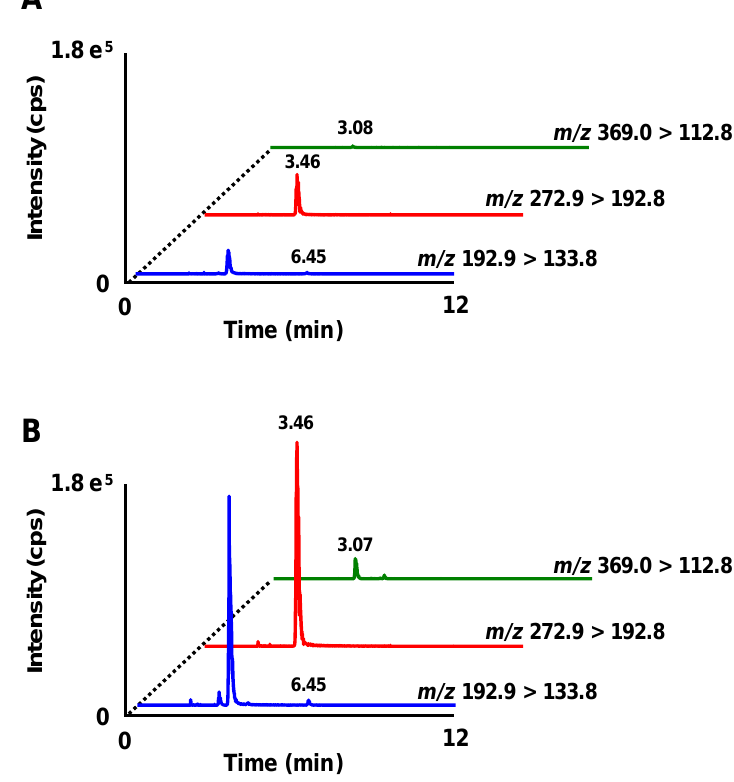
Figure 4. Typical MRM chromatograms of FA and FA conjugates in plasma before ( A ) and 6 h after RBOZ administration ( B ). Each MRM pair represents analysis of the following FA and FA conjugates: m / z 192.9 > 133.8, ferulic acid; m / z 272.9 > 192.8, ferulic acid 4- O -sulfate; m / z 369.0 > 112.8, ferulic acid 4- O - β - d